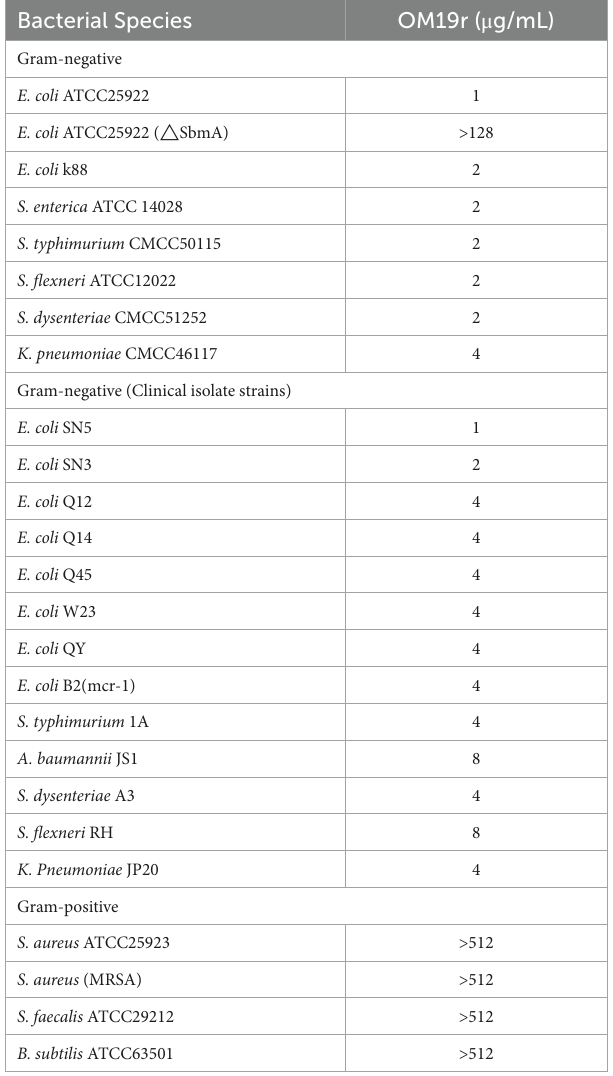
TABLE 1 Minimum inhibitory concentrations (MICs) of OM19r against different bacteria. Bacterial